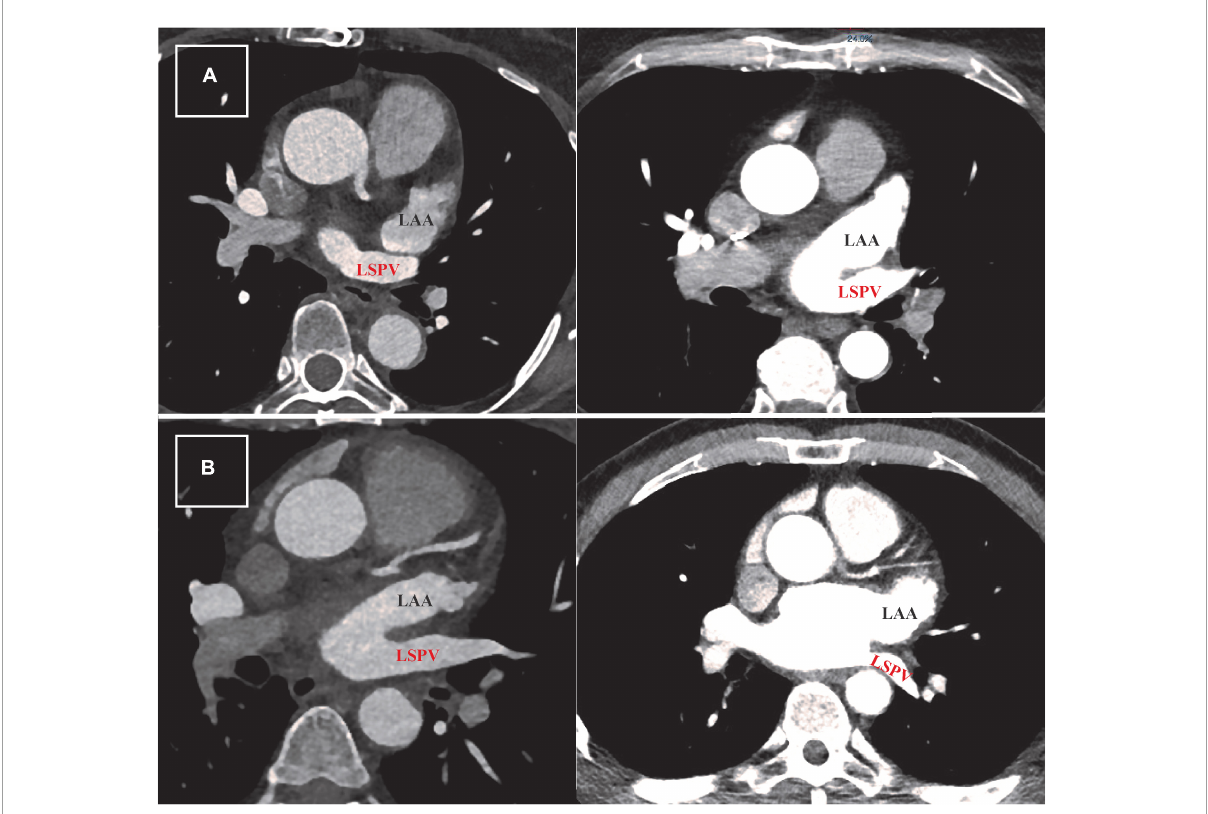
FIGURE1 Defining abutting and non-abutting left atrial appendage–left superior pulmonary vein (LAA-LSPV). (A) Two examples of cardiac computed tomography (CT) scans from patients with abutting LAA (written in black) and LSPV (written in red). The measured distance between LAA and LSPV in these cases was less than 2 mm. (B) Two examples of CT scans from patients with persistent atrial fibrillation showing different trajectory of non-abutting LAA and LSPV. The measured distance between these two structures was more than 2 mm in both patients.